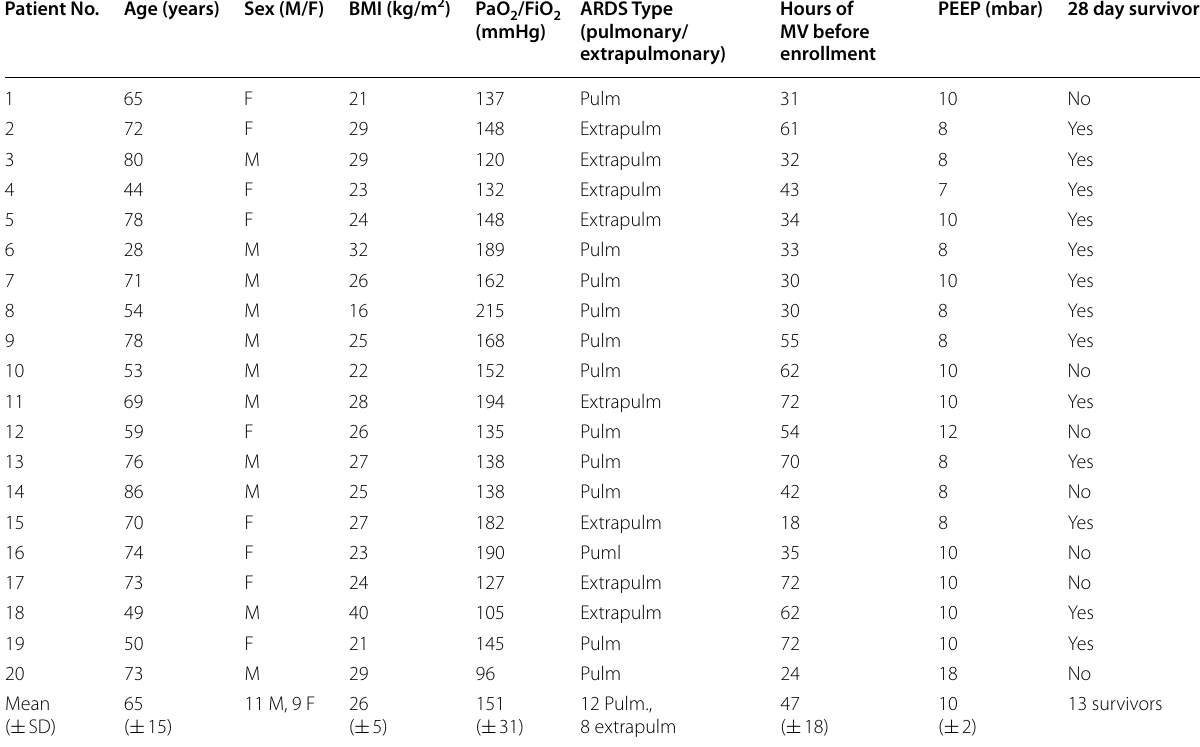
Table 1 Main characteristics of the study